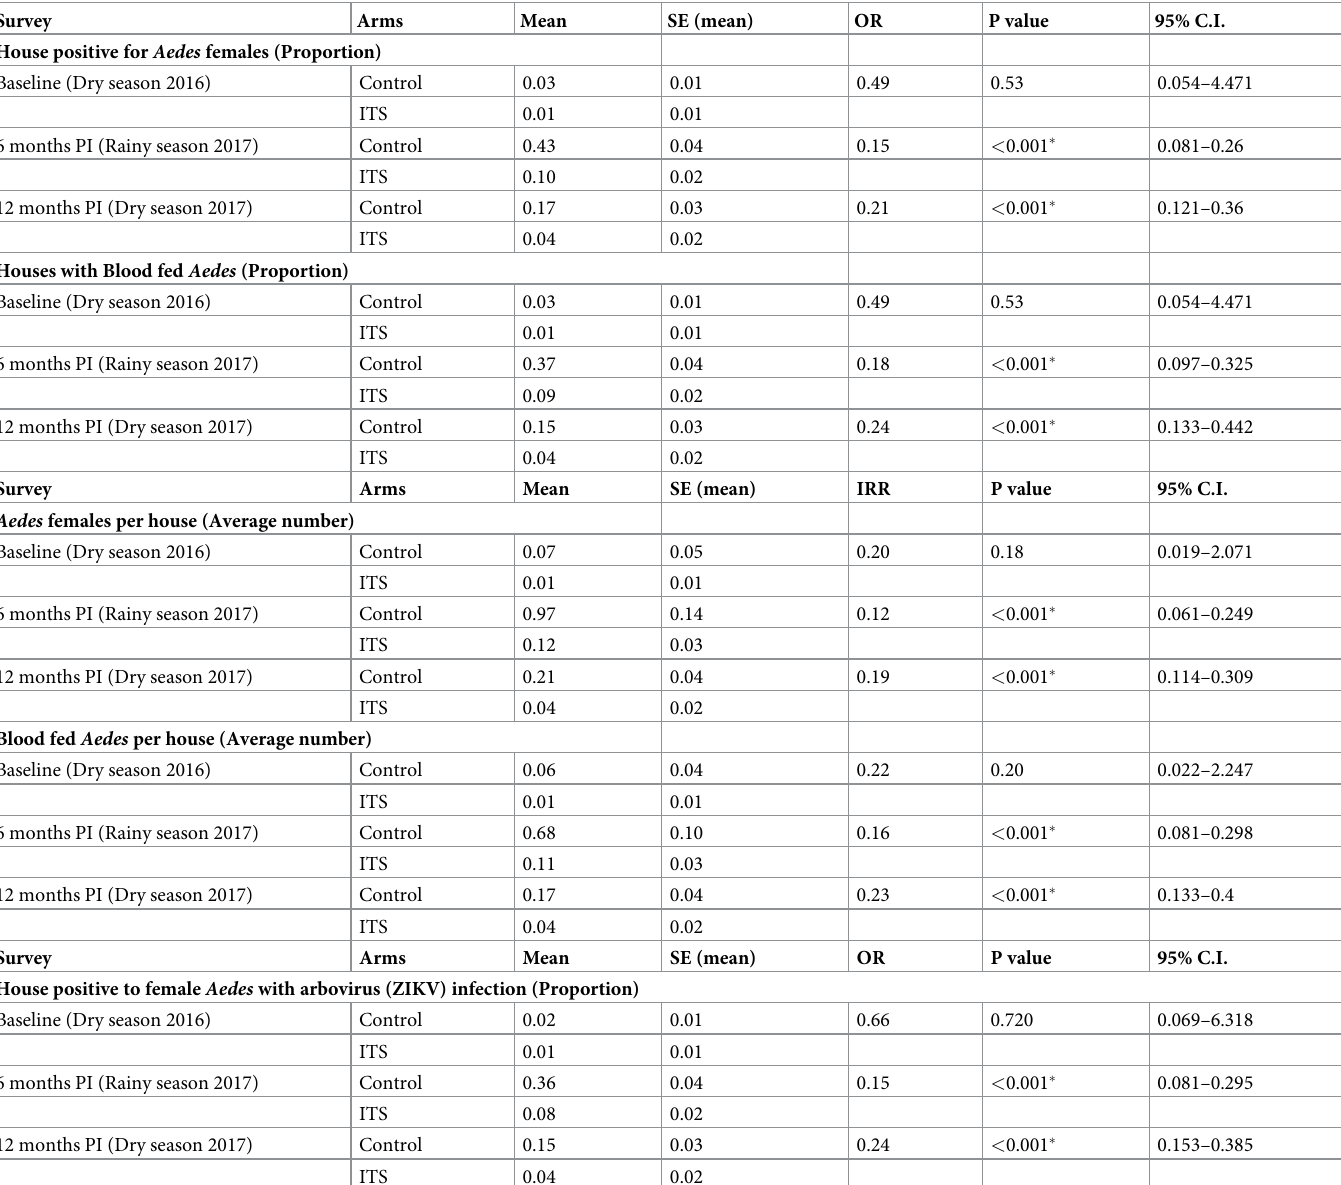
Table 1. Comparison of Ae . aegypti indoor-adult-based entomological indicators between treated (ITS) and untreated (control) groups at Juan Pablo II houses (n = 900) in Merida, Mexico. Odds ratios (OR) and incidence rate ratios (IRR) with 95% confidence intervals are shown.